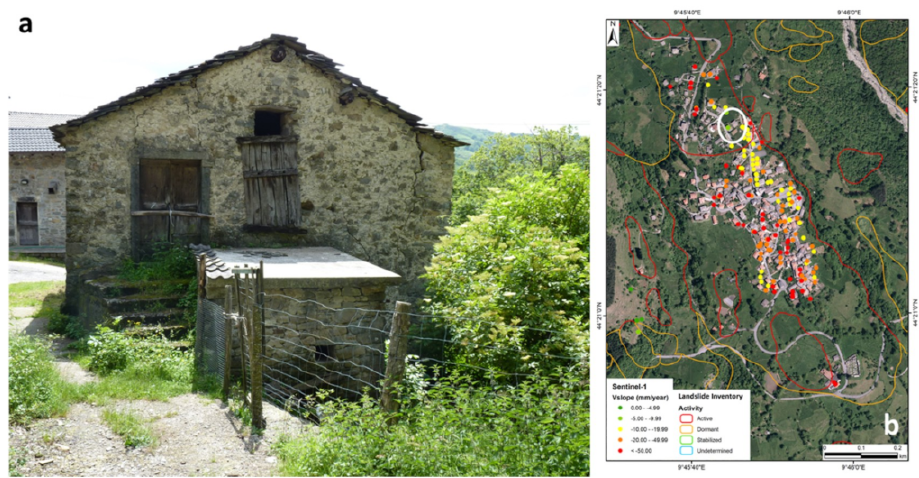
Figure 11. Abandoned edifices ( a ), classified as damaged, in the northern portion of the hamlet where the Vslope are values lower than − 10 mm / year (with circle in b